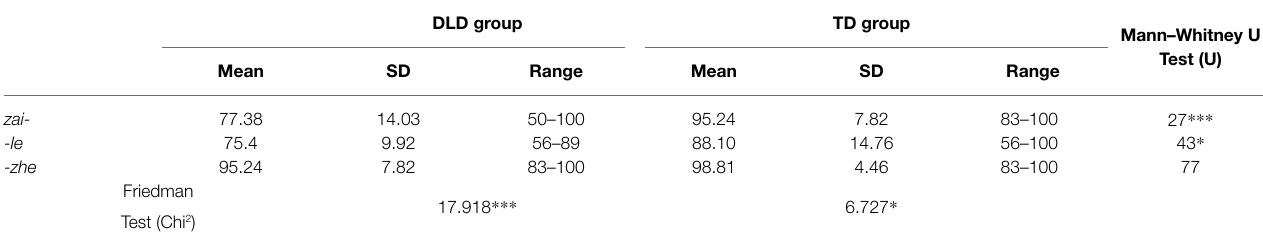
TABLE 4 | Accuracy score (%) for each aspect marker.